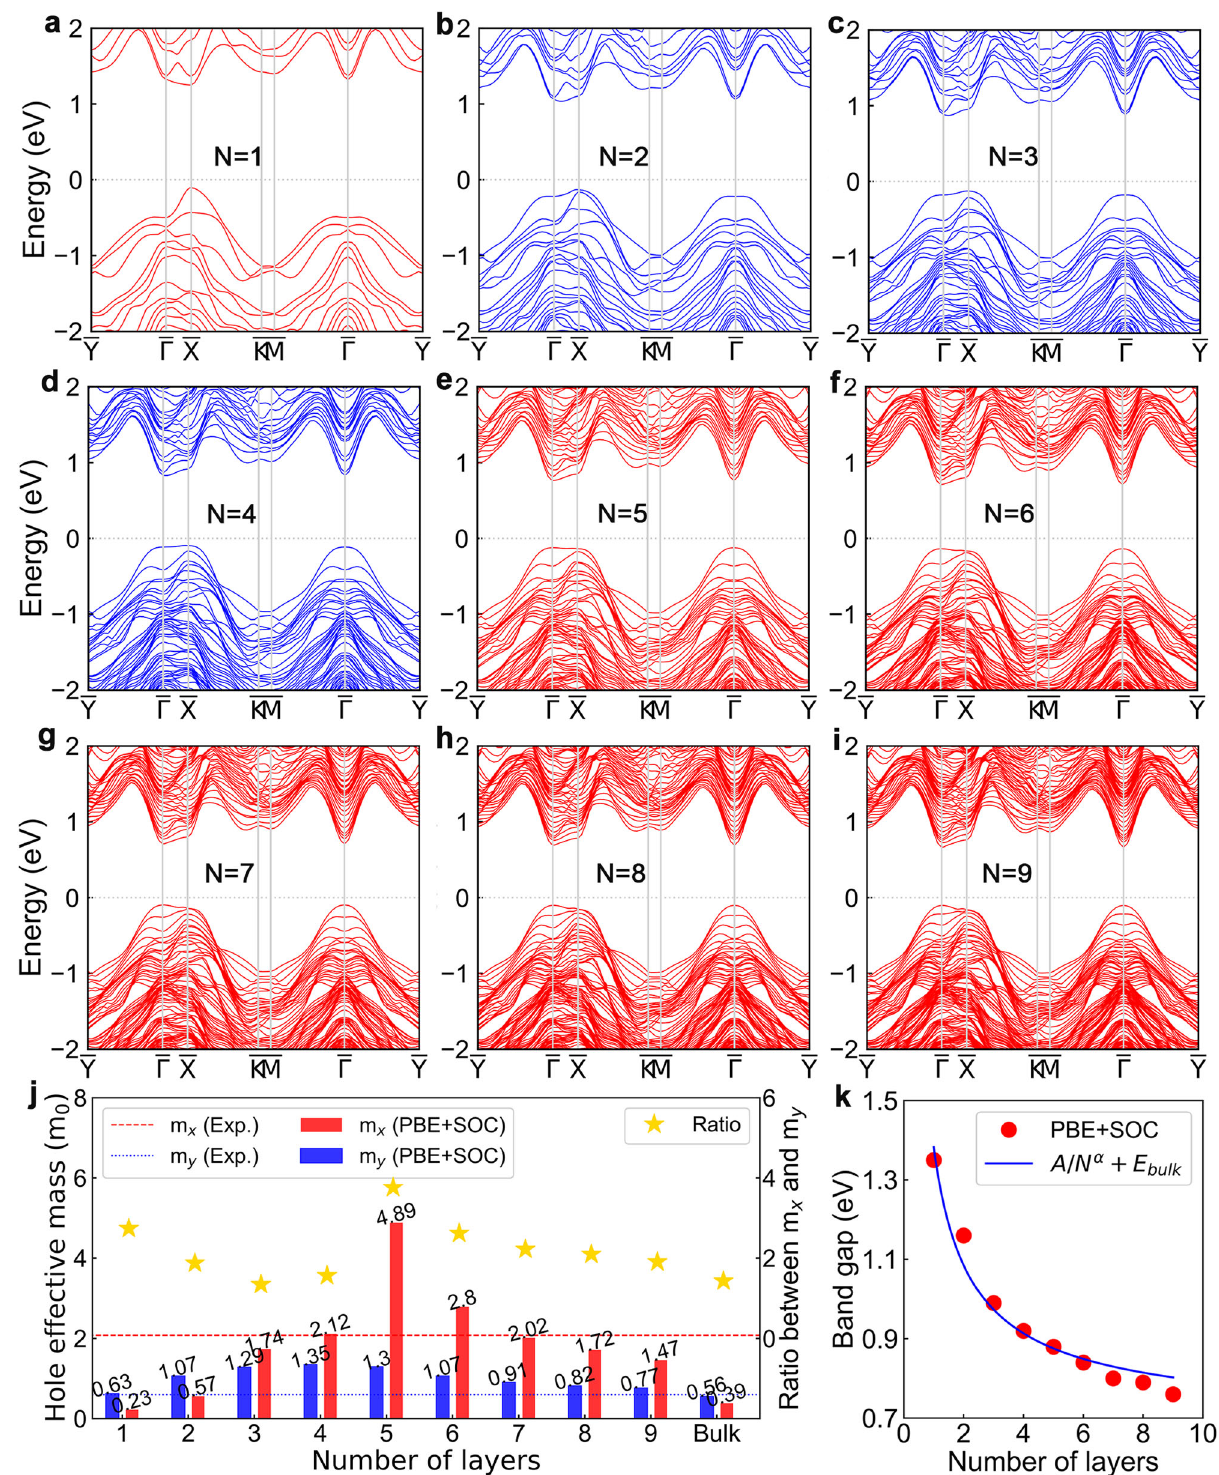
Fig. 3 Layer-dependent band structures in GaTe. a – i Band structures of GaTe with the number of layers (N) increasing from 1 to 9. j Evolution of hole effective masses along the x and y directions (m x and m y ) in units of free electron mass m 0 , and the ratio between m x and m y with number of layers. k Band gap evolution as function of number of layers for GaTe. These results are calculated by the PBE + SOC First-principles calculations . The density functional theory calculations were optB88 30,31 van der Waals density functional was used in optimizing the system performed within the projector augmented-wave method 25,26 implemented by geometry. The spin-orbit coupling (SOC) effect is known to be proportional to Z 4 using Vienna ab initio simulation package 27,28 , with a kinetic energy cutoff of (Z is a nucleus charge) and plays an important role in the heavy element layered 500 eV for plane-wave basis set. The generalized gradient approximation in the system 32 . Therefore, the SOC effect has been included in the band structure cal- Perdew-Burke-Ernzerhof (PBE) implementation 29 was chosen as the exchange culation. The Brillouin zone was sampled with Γ -centered Monkhorst-pack grid 33 correlation functional, respectively. To capture the interlayer spacing of GaTe, the of 8 ×8 ×8 and 4 ×16 ×8 for the bulk primitive and unit cell, and 8× 8× 1 for the